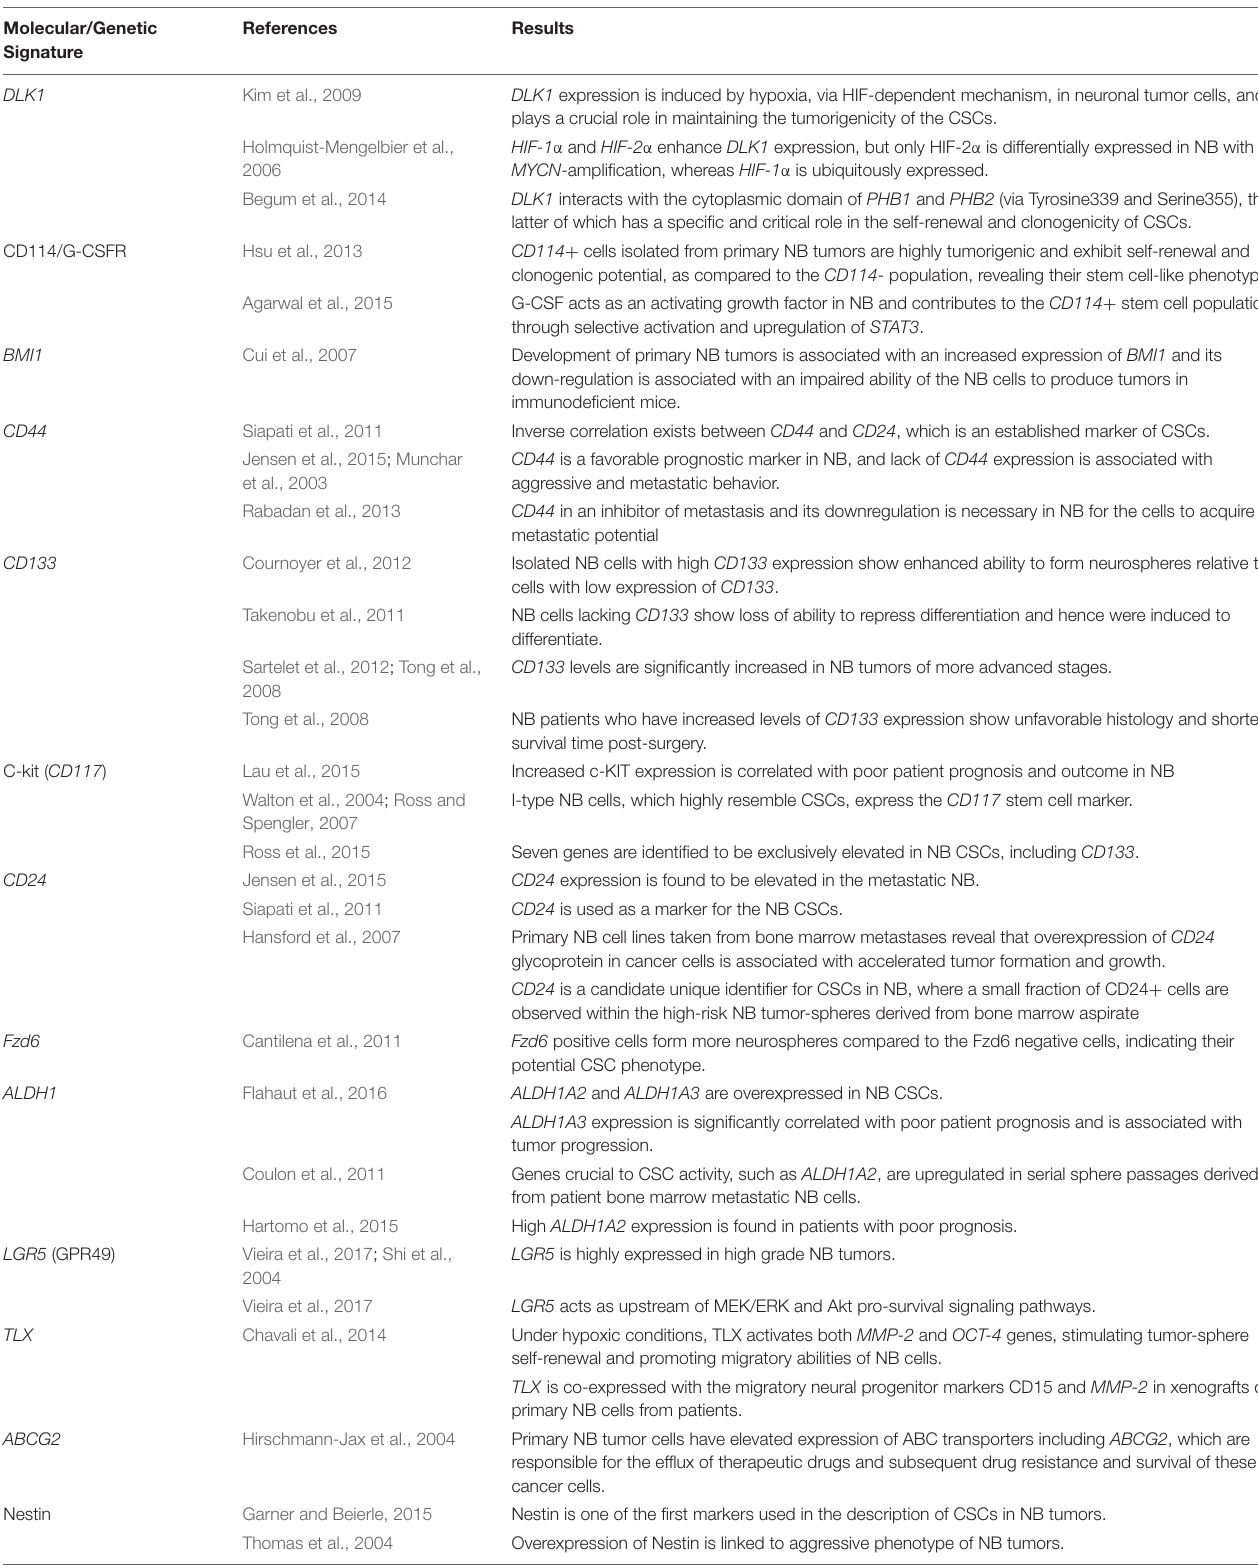
TABLE 1 | Summary table of the major molecular signatures and genetic aberrations attributed to neuroblastoma cancer stem cells. Molecular/Genetic